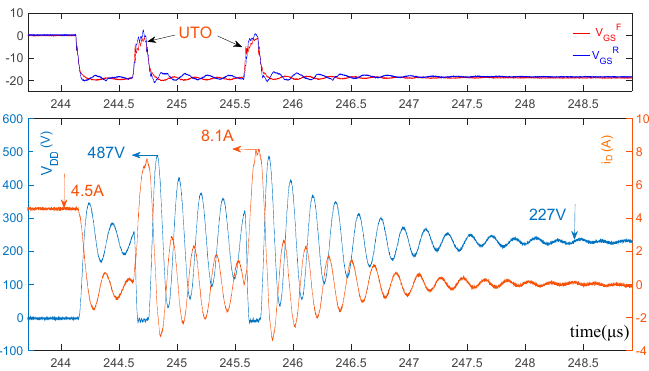
Figure 14. Turn-off transient under the condition of V in = 227 V, I L = 4.5 A, C X = 0.22 nF.